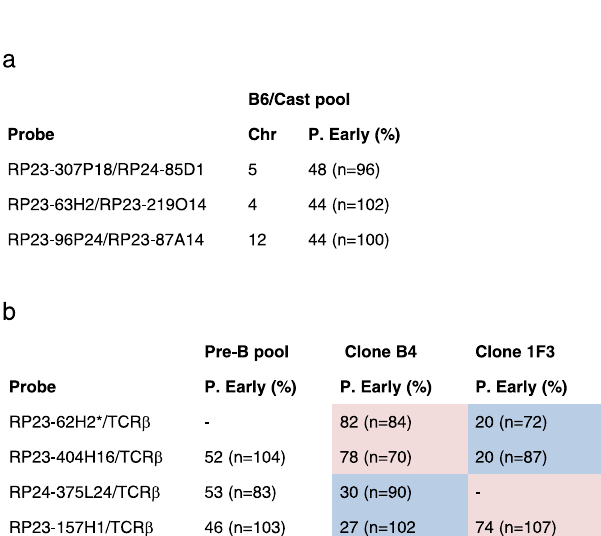
Fig. 5 Asynchronous replication orientation. Double-label FISH analysis was carried out on a pool of B6/Cast pre-B cells ( a ), as well as a pool of pure B6 pre-B cells carrying a large Tcr β deletion on the paternal allele of Chr6 and two individual clones (B4 and 1F3) isolated from this population ( b ). In each FISH experiment, one fl uorescent probe (listed fi rst) was speci fi c for an asynchronous replicating region, while the second probe (listed second) was used to speci fi cally detect the nondeleted maternal allele using either the Tcr β probe on Chr6 or probes speci fi c for regions naturally deleted on the Cast allele (paternal). Nuclei with single/double signals were selected and counted to determine the percentage having an early paternal allele (double). The p value for pools was >0.1 and for speci fi c clones, <10 − 4 as determined by the two-tailed binomial test. Paternal early (red background) or maternal early (blue background) are marked. The fi rst two probes and the last two probes are located in regions determined by whole-genome analysis to be antiparallel. (*) Note that this is the probe for the olfactory receptor region on